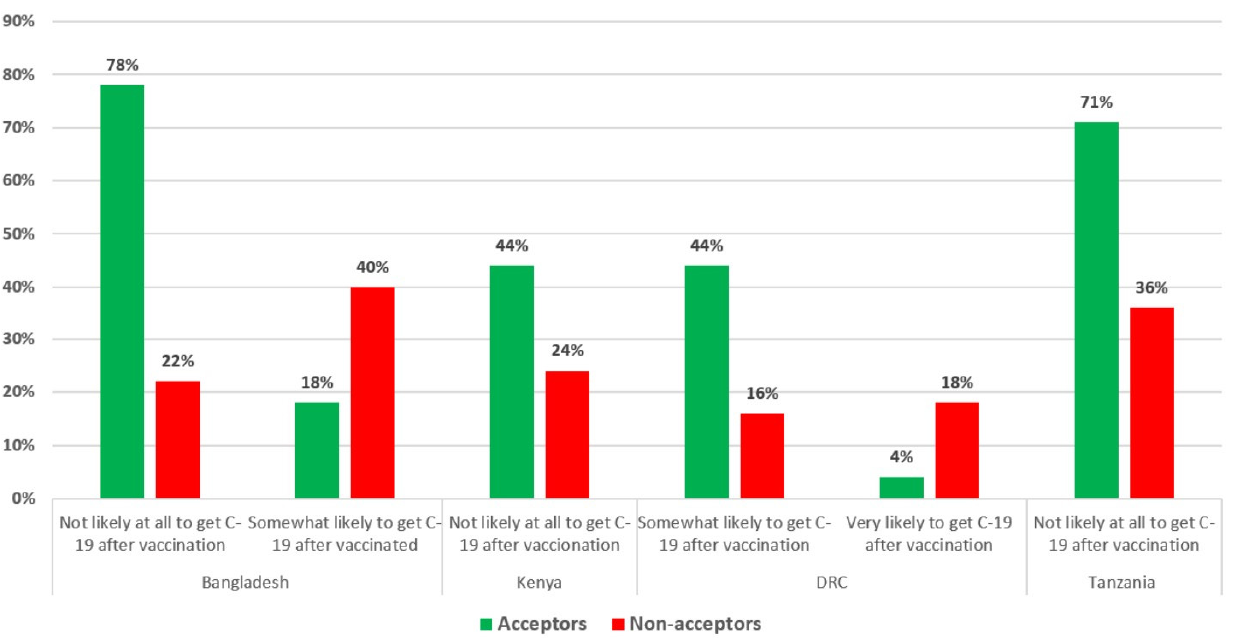
Figure 4. Acceptors’ and Non-acceptors’ beliefs on the safety of getting a COVID-19 vaccine by country.